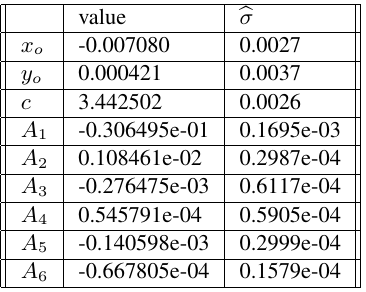
Table 4: Results of the interior orientation of one arbitrary